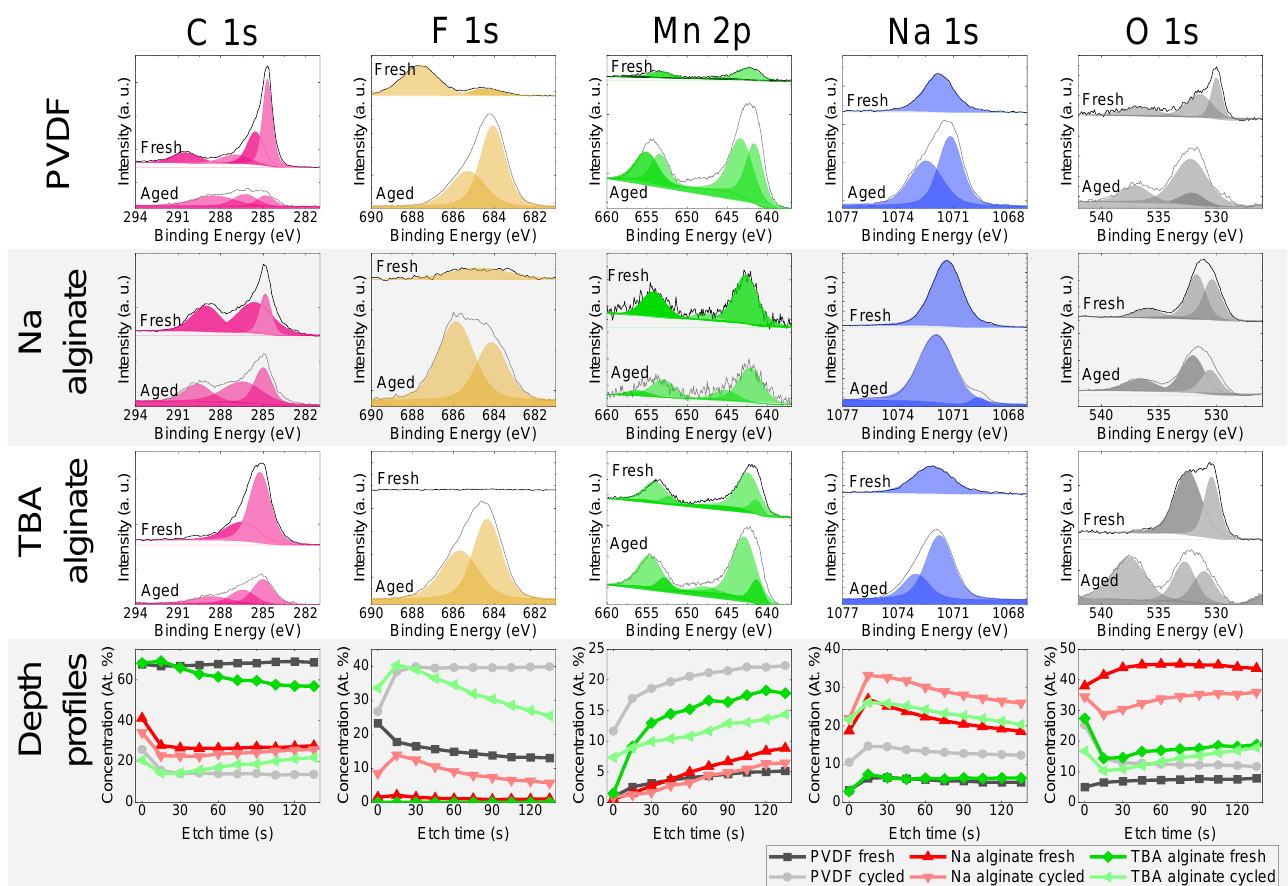
Figure 8. XPS results of Na 0.67 MnO 2 electrodes for fresh and aged (cycled) electrodes that have undergone 500 charge-discharge cycles at 1 C (175 mA/g) rate — individual spectra and compositional analysis.